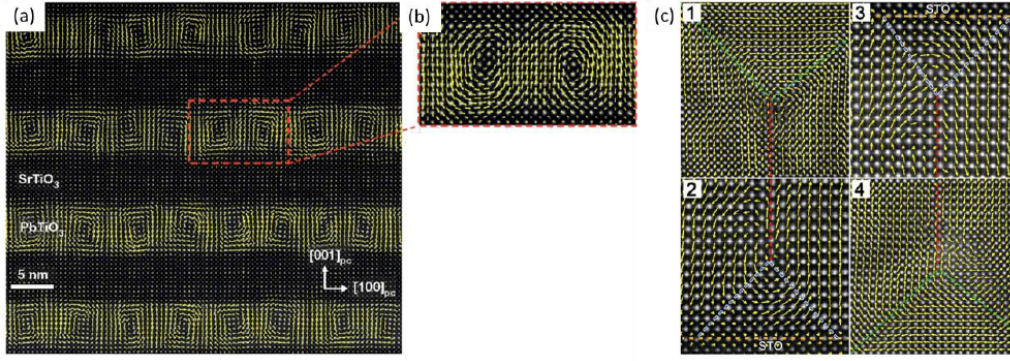
Figure 3. Scanning transmission electron microscopy on complex polar domains. ( a ) Observation of ferroelectric vortices in PTO/STO superlattice. Reprinted by permission from [48], Copyright Macmillan Publishers Ltd., 2016. ( b ) Close-up into a single vortex. ( c ) Flux-closure domain patterns in a PTO/STO multilayer system. From. Reprinted with permission from [65], Copyright AAAS,